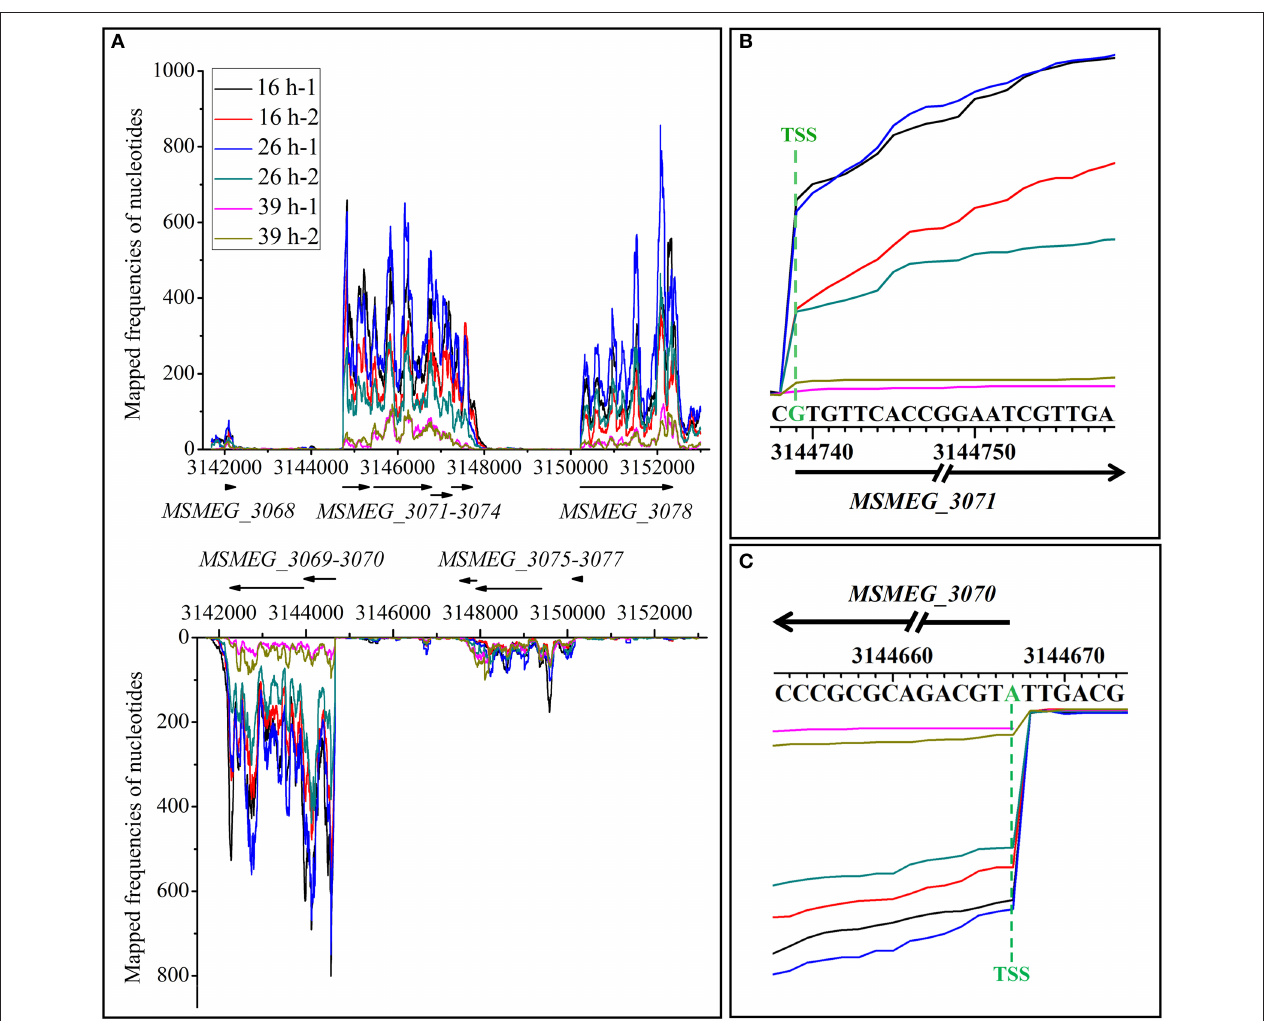
FIGURE 4 | Transcriptional maps of MSMEG_3068-3078 loci. (A) Whole view of strand-specific transcriptional maps of MSMEG_3068-3078 loci. MSMEG_3068, MSMEG_3071-3074, and MSMEG_3078 genes residing in the positive strand while genes of MSMEG_3069-3070 and MSMEG_3075-3077 are located in the negative strand. (B) Single-nucleotide resolution transcriptional maps of MSMEG_3071 and its TSS. (C) Single-nucleotide resolution transcriptional maps of MSMEG_3070 and its TSS. Lines of different colors represent samples in different growth phases, − 1 and − 2 represent the two biological replicates. The same as